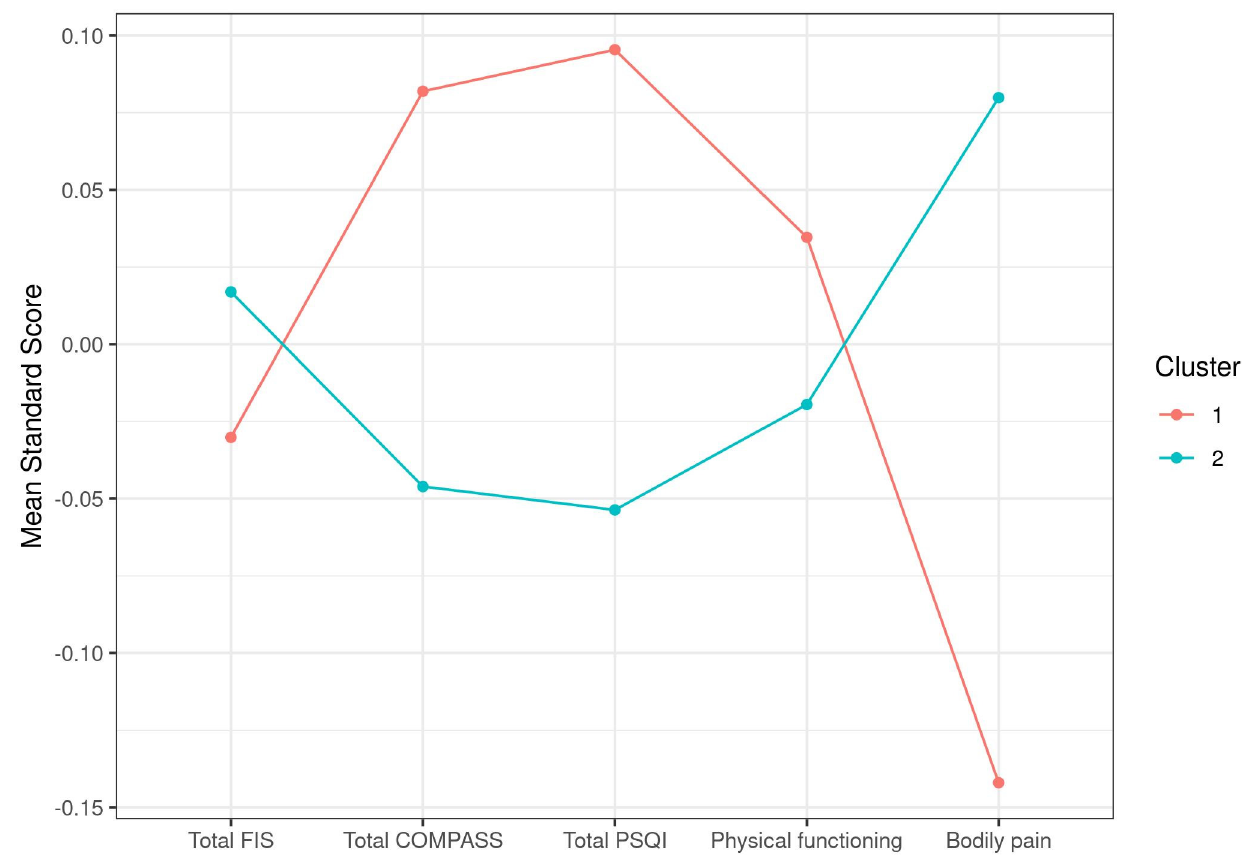
Figure 3. Graphic representation of ME/CFS symptom standard score differences in relation to C1q stratification.